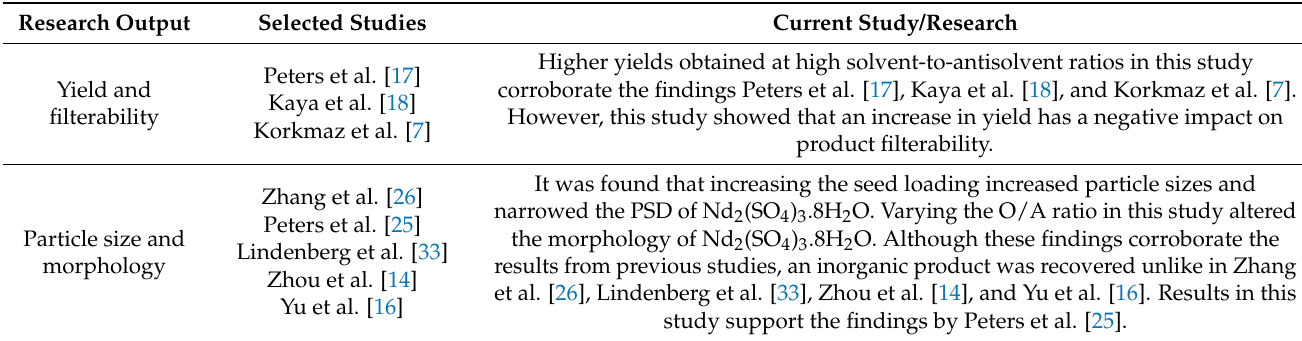
Table 2. Comparison of yield, filterability, and physical properties of the product obtained in this study versus previous